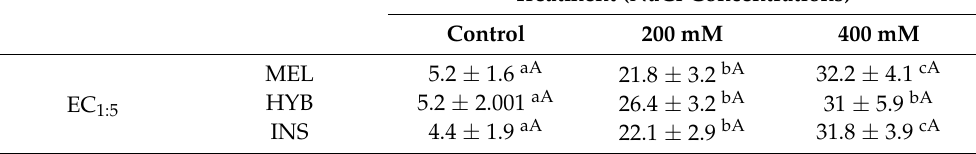
Table 1. Electrical conductivity values (EC 1:5 mean ± SD; n = 5) in the pot substrates of Solanum melongena (MEL) , Solanum insanum (INS) and their hybrid (HYB), when applying the salt treatments. Different lowercase letters within the same row indicate statistically significant differences between treatments, and different uppercase letters within the same column indicate statistically significant differences between genotypes ( p < 0.05), according to the Student–Newman–Keuls multiple range test.